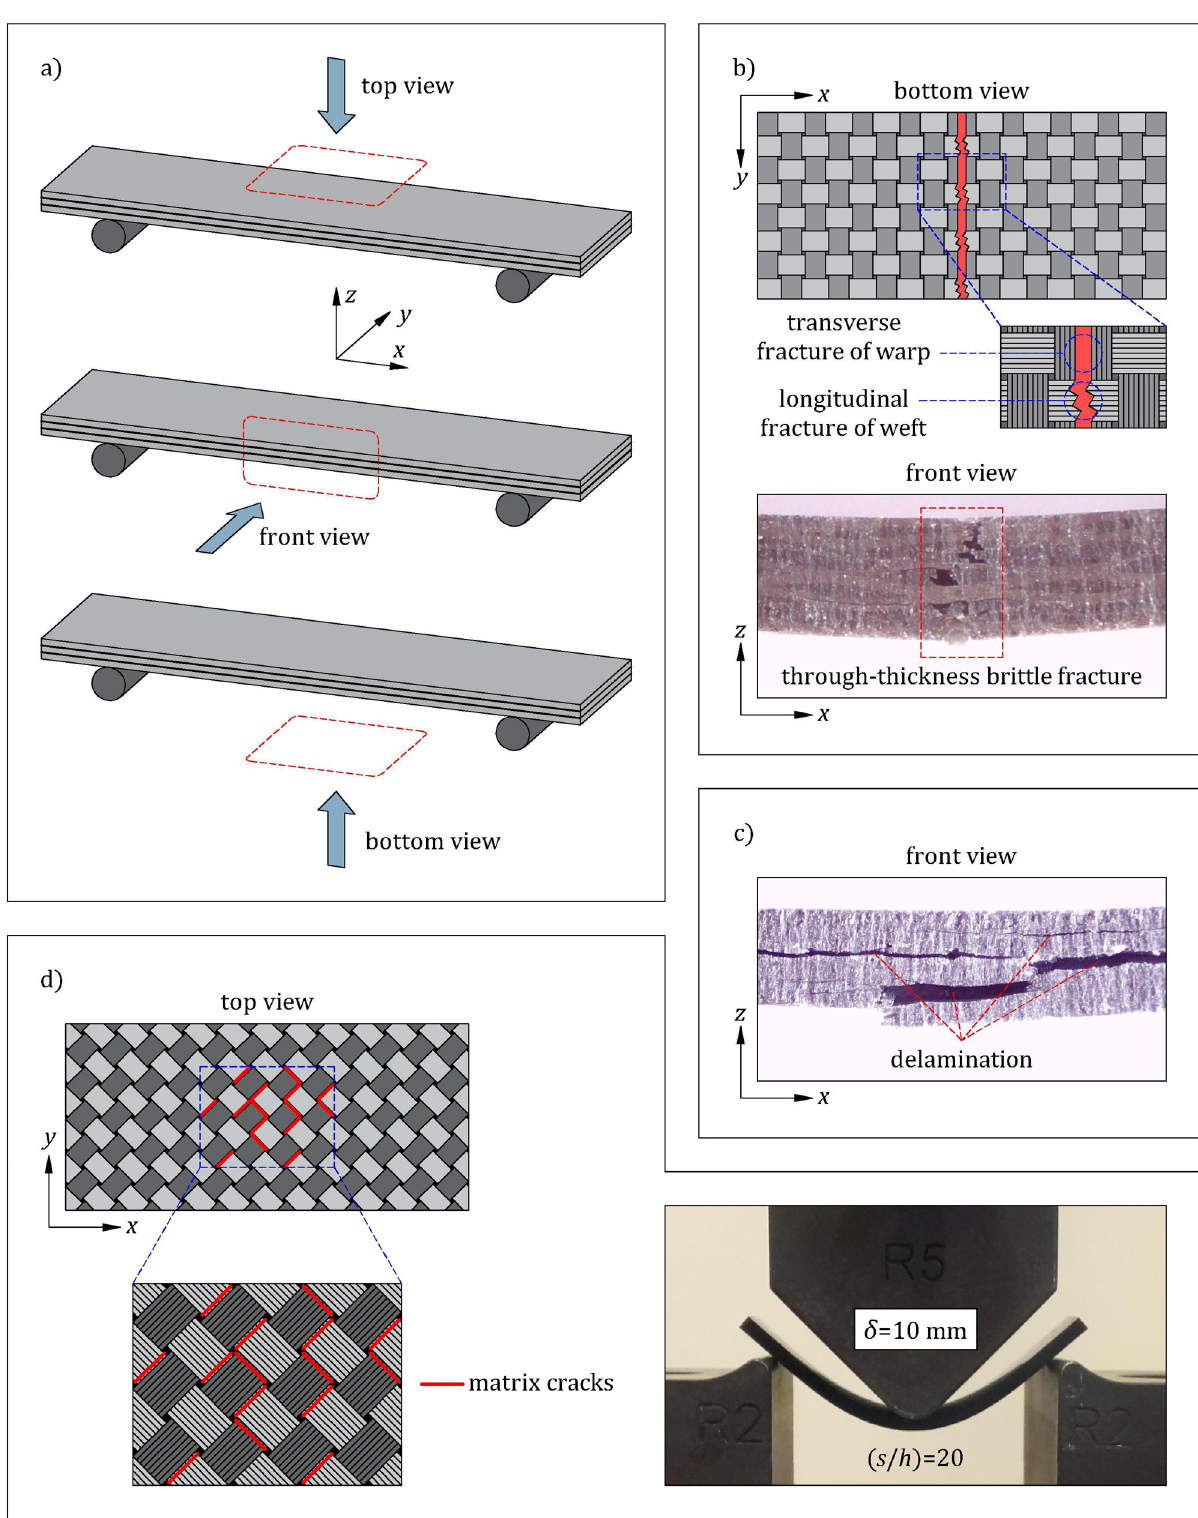
Figure 10: Visual inspection of the selected laminate specimens after the completion of the fl exure tests. ( a ) Top, front and bottom view de fi nition; ( b ) brittle fracture of CL ⊞ ( 16 ) and CL ⊞ ( 20 ) specimens; ( c ) CL ⊞ ( 40 ) specimen with delamination and ( d ) cracks on the upper surface of CL ⊠ ( 16 ) and CL ⊠ ( 20 ) specimens and large de fl ection of CL ⊠ ( 20 )